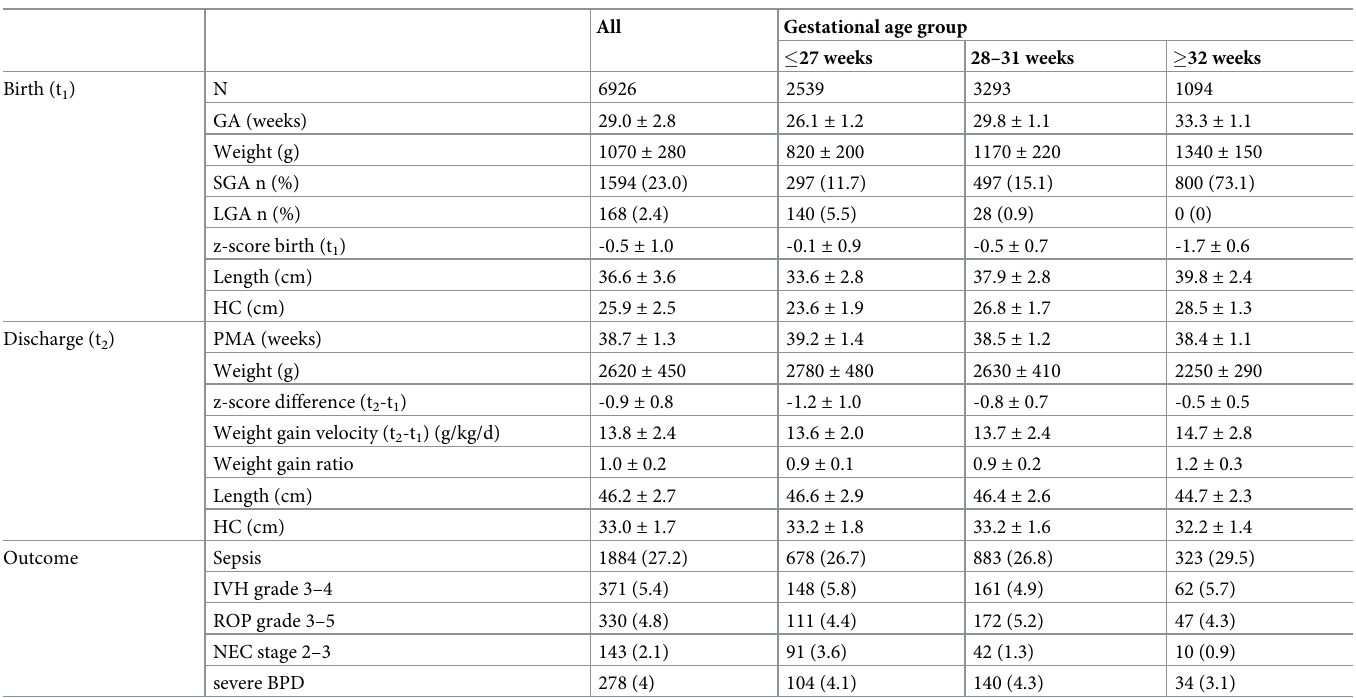
Table 1. Patient